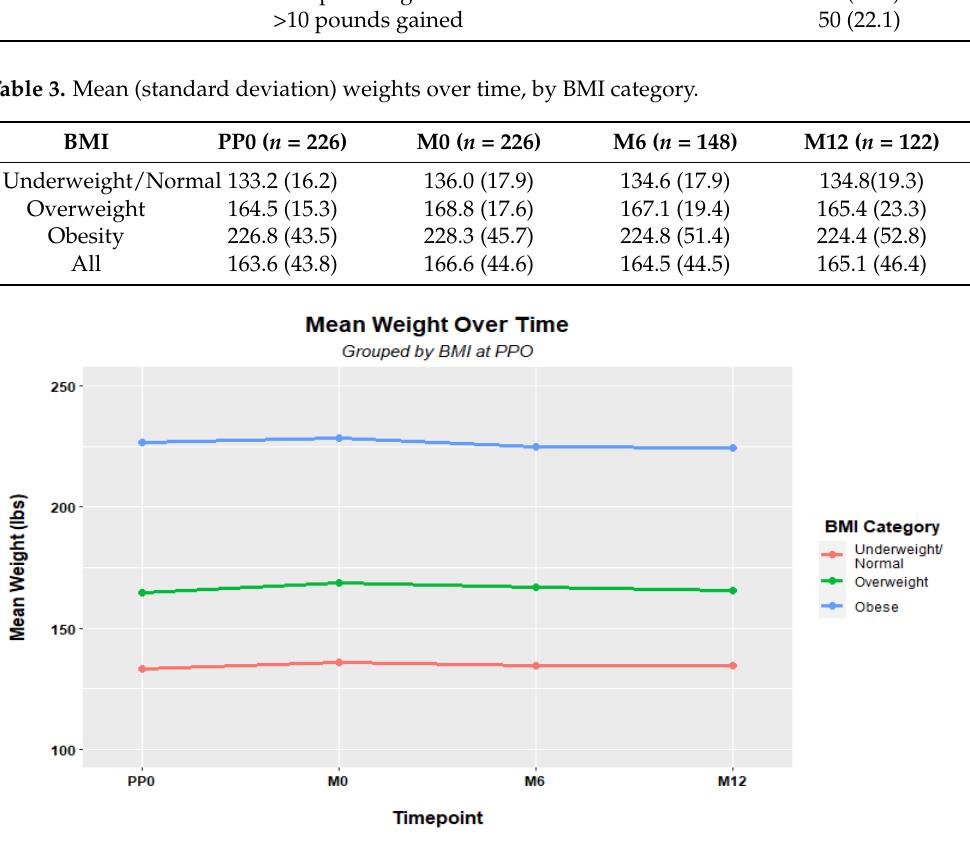
Figure 1. Mean weight over time by BMI